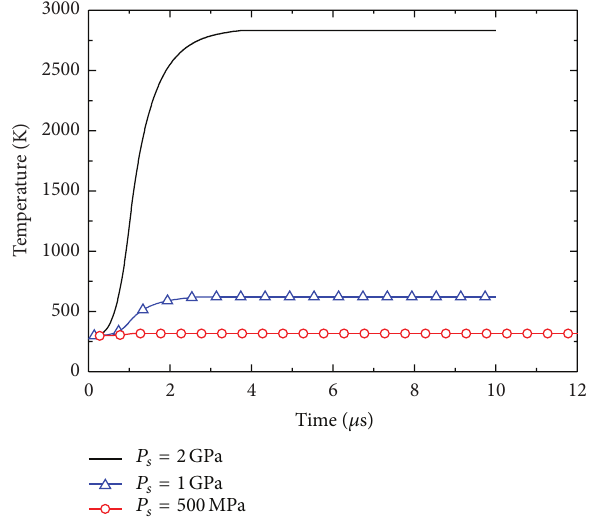
Figure 4: Timeevolution of temperatureat poresurfaceunderthree different external pressures with Whitworth model.